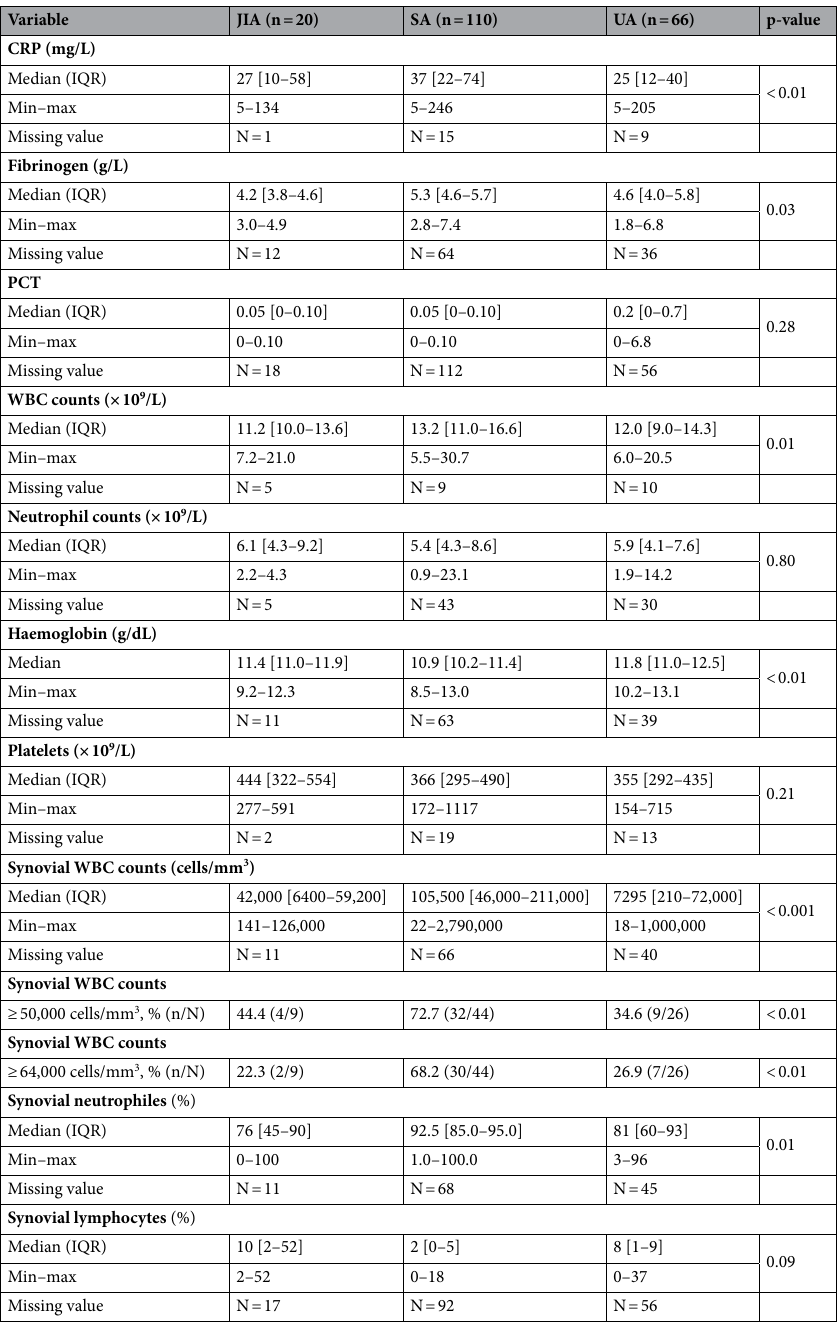
Table 2. Biological characteristics of children with septic arthritis, juvenile idiopathic arthritis and arthritis with no definitive diagnosis. SA septic arthritis, JIA juvenile idiopathic arthritis, UA undetermined arthritis a , IQR interquartile range. a Arthritis with no established association with infection, that did not fulfil the classification criteria for JIA or other well-established